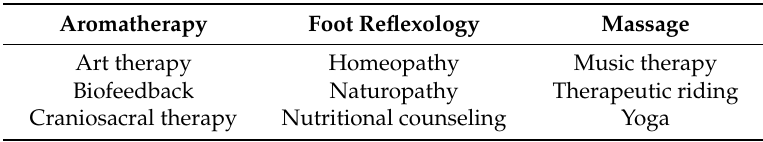
Table 1. Existing staff expertise within St. Marien revealed through